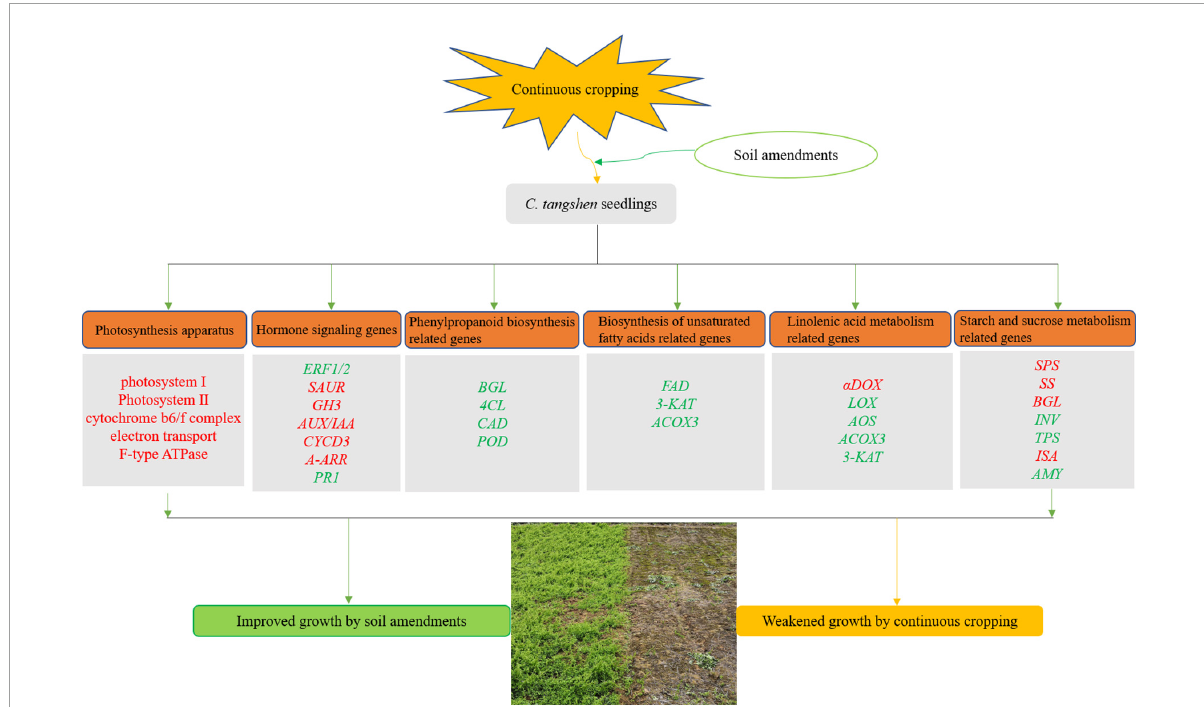
FIGURE10 A hypothetical model of soil amendments induced response in continuously cropped C. tangshen . The apparatus or genes labeled with red were up regulated, while labeled with green were down